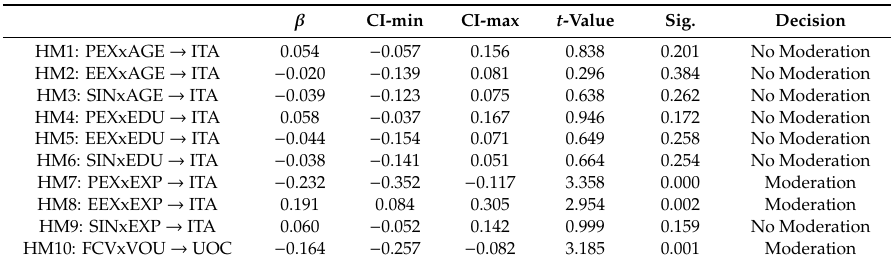
Table 5. Moderating E ff ect.